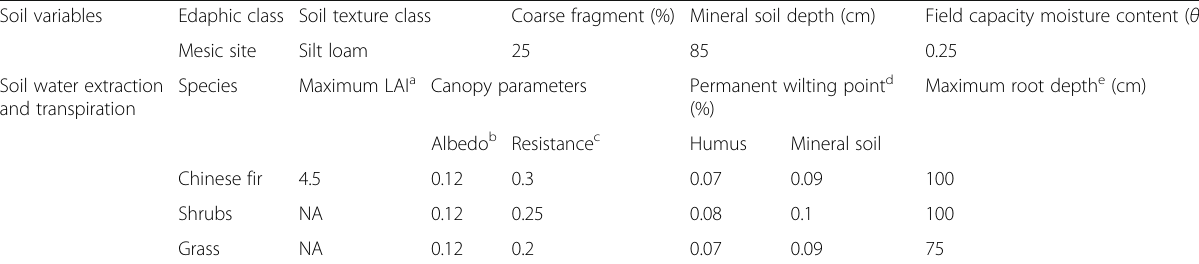
Table 1 Parameter values in the ForWaDy submodel relevant for the simulation of plant available water, transpiration and water stress on a mesic